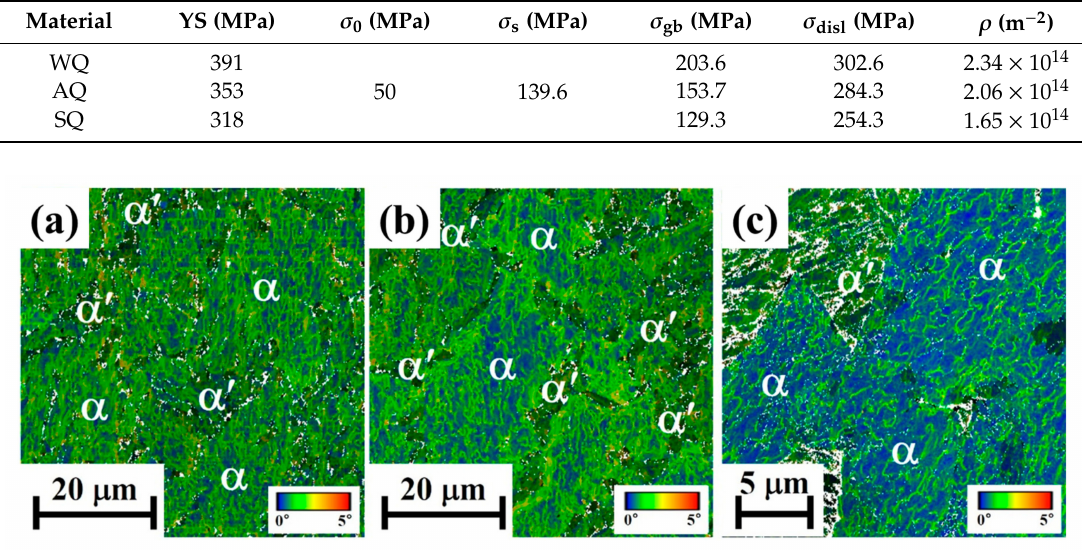
Figure 4. Kernel average misorientation maps for ( a ) WQ specimen, ( b ) AQ specimen, and ( c ) SQ specimen; 0 ◦ and 5 ◦ are set to be the minimum and maximum misorientation angles,